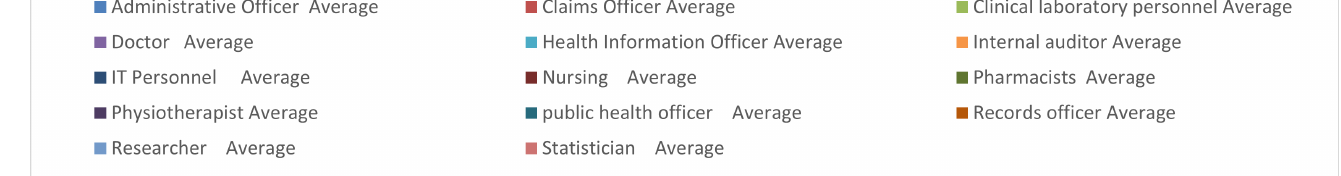
Figure 4. Comparison of KAB security practice risk among healthcare staff.